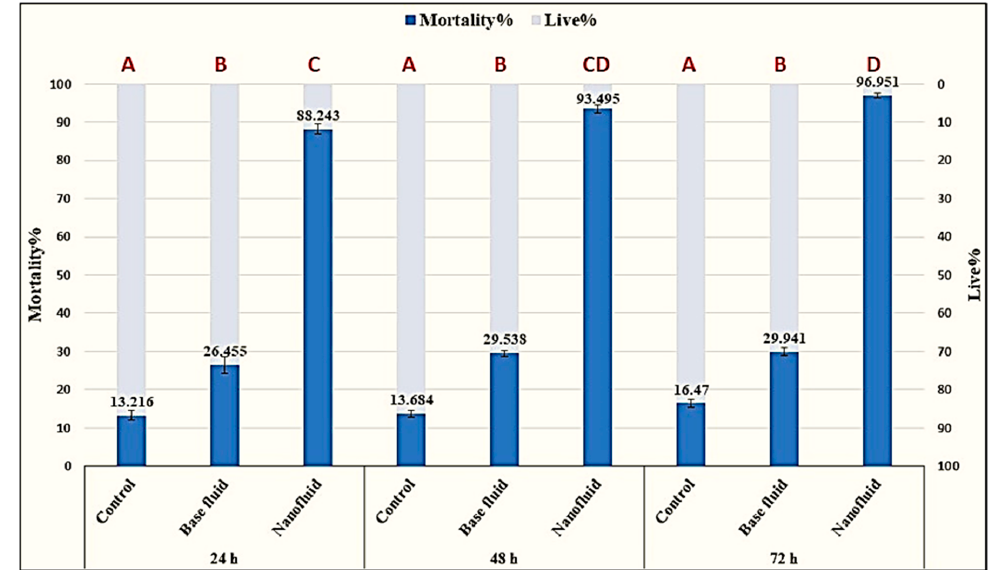
Figure 7. The percentages of deaths induced by ZnO-NPs after 24, 48 and 72 h of treatment; highly significant activity determined by the Tukey pairwise comparison test ( p 0.05). letter “A” represent non sifnificance among control samples; ‘B” represent non significance among base fluid samples; “C & CD” represent the significance between ZnO-NPs at time 24, 48 and 72 h. the highly significant activity was denoted with the letter ”D”.